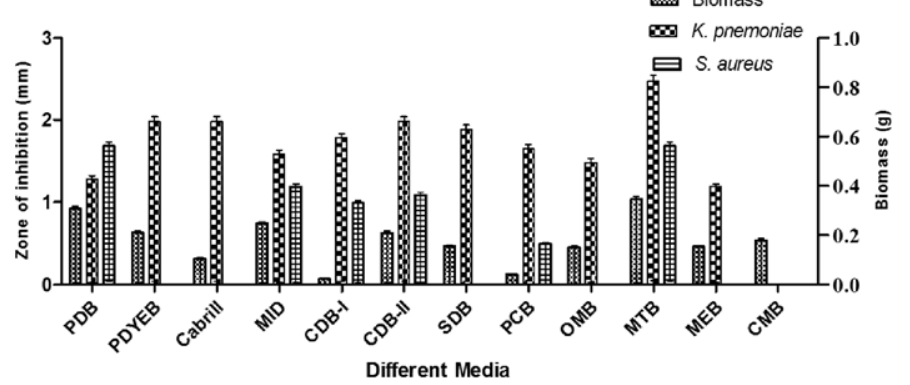
Fig. 2. M. karstenii growth comparison in various media and antibacterial activity.